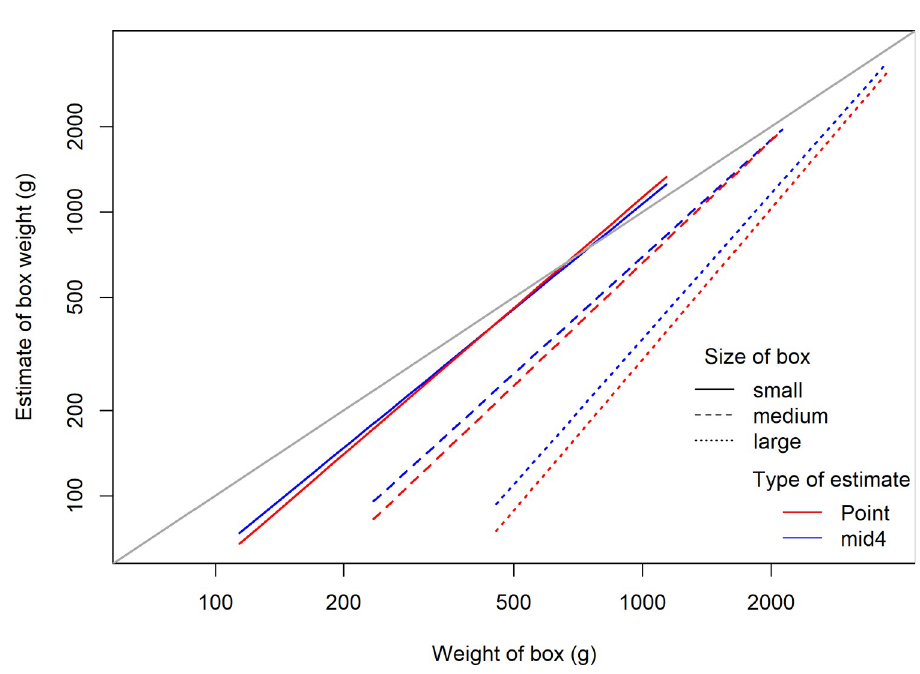
Fig 6. Slope estimates for log of point judgments and log of mid4 in grams. Main effects: the log of the true box weight, the type of judgment estimate (point vs mid4), and size (small, medium, large). The model also contains first-order interaction effects, and random effects of, log of true weight, type of judgment estimate, and size. The numerical model estimates can be found in S1 Table.